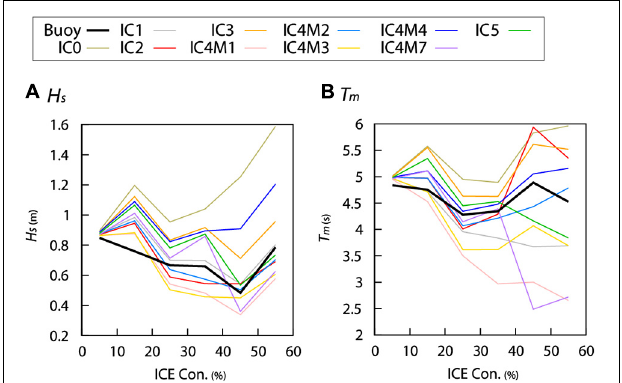
FIGURE 5 | (A) H s and (B) T m averaged from the ST6 model simulations and NOWPHAS buoy as a function of ice concentration in 10% bins. The source terms of S ice are represented by the different colored lines and identified in the legend panel. The horizontal axis denotes the ice concentration in the